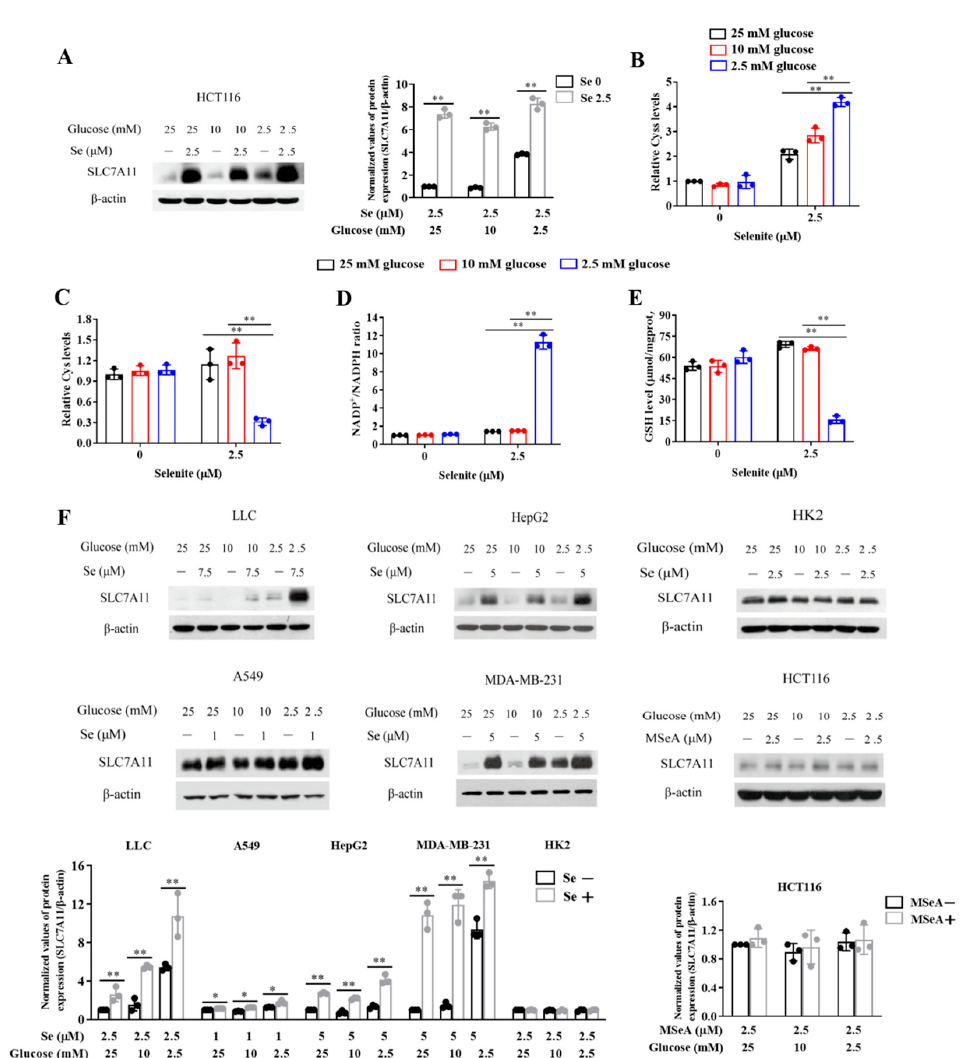
Figure 3. Expression of SLC7A11 is up ‐ regulated by selenite, accompanied by cystine accumulation, cysteine reduction and NADPH depletion in the context of glucose deprivation. ( A ) SLC7A11 protein levels of HCT116 treated with or without selenite in different concentrations of medium glucose for 22 h. ( B – E ) Cyss levels ( B ), Cys levels ( C ), NADP+/NADPH ratios ( D ) and GSH levels ( E ) of HCT116 cells cultured in the medium containing indicated concentrations of glucose with or without treatment of selenite for 22 h. ( F ) SLC7A11 protein levels of LLC, A549, MDA ‐ MB ‐ 231, HepG2 and HK2 cells treated with or without selenite in different concentnations of medium glucose for 22 h, 30 h, 30 h, 30 h and 48 h, respectively; SLC7A11 protein levels of HCT116 cells treated with or without MSeA in different concentnations of medium glucose for 22 h. Results are representative of three biologically independent experiments. Data are expressed as mean±SD, * p < 0.05, ** p < 0.01. Cyss: cystine; Cys: cysteine; NADP+: oxidized form of nicotinamide ‐ adenine dinucleotide phosphate; NADPH: reduced form of nicotinamide ‐ adenine dinucleotide phosphate; GSH: glutathione; Se: selenite; MSeA: methylseleninic acid.